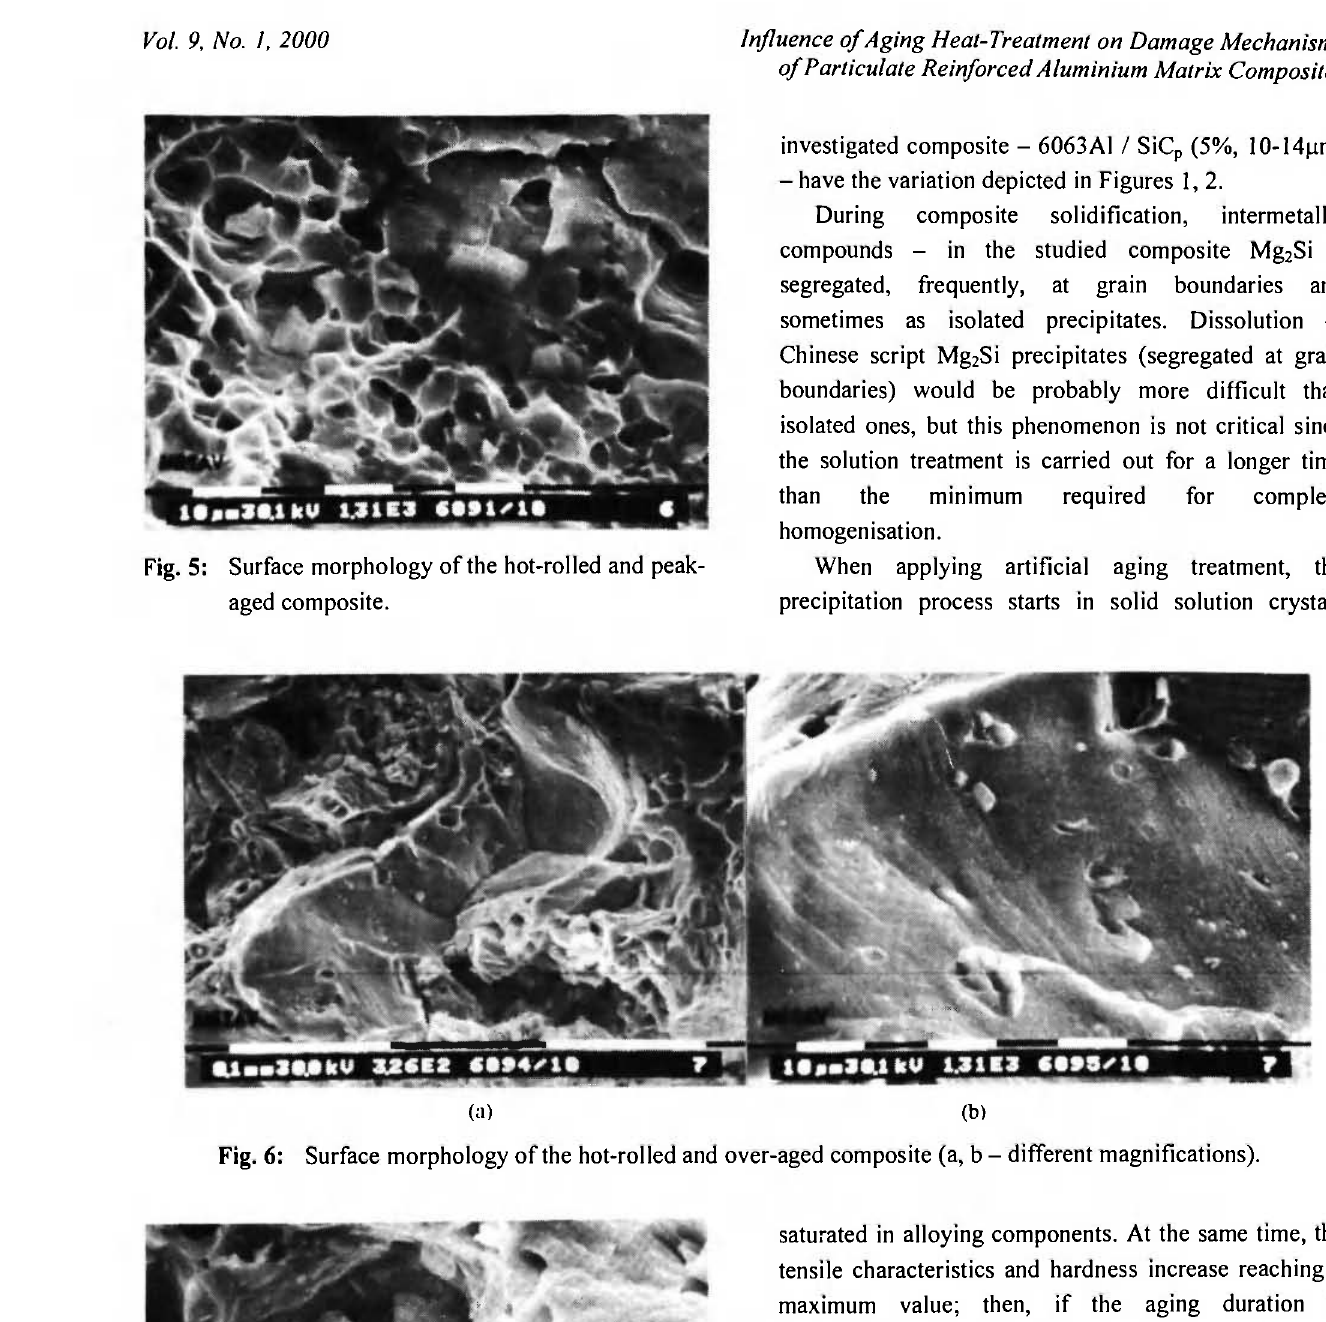
Fig. 6: Surface morphology of the hot-rolled and over-aged composite (a, b - different magnifications).